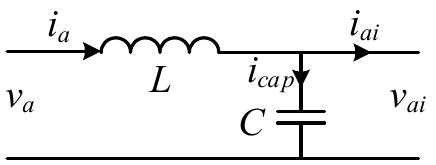
Figure 5. The equivalent circuit of the input filter for phase a.